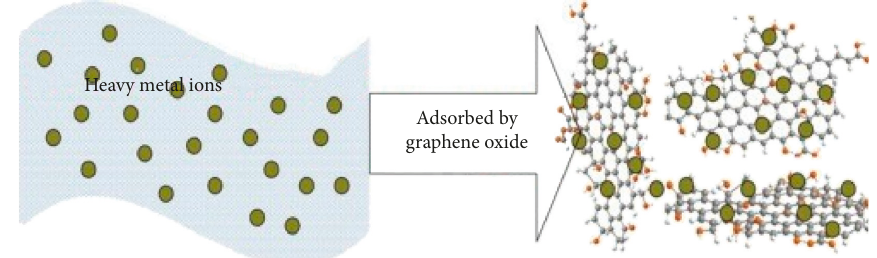
Figure 20: Metal ions adsorbed by graphene